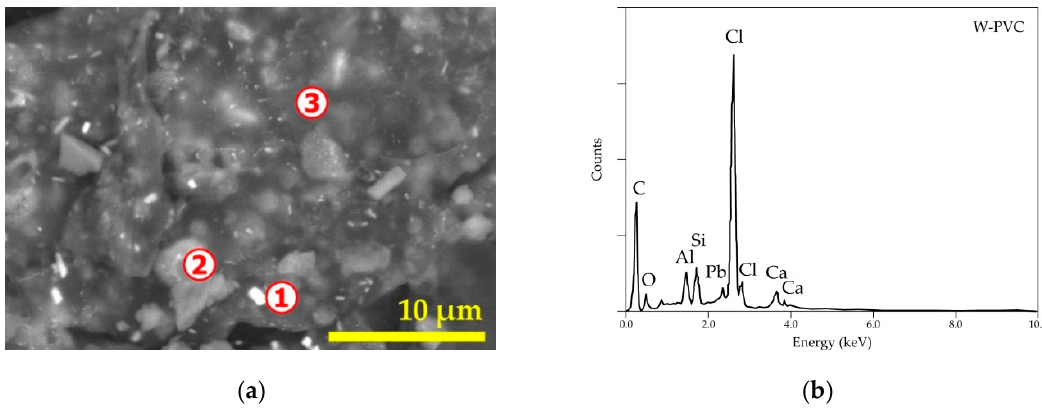
Figure 3. SEM-EDS results of initial PVC waste: ( a ) general view (backscattered electron micrograph “BSE”) of the sample and numbers 1–3 indicate the locations for microanalysis; ( b ) overall EDS spectrum of the sample.